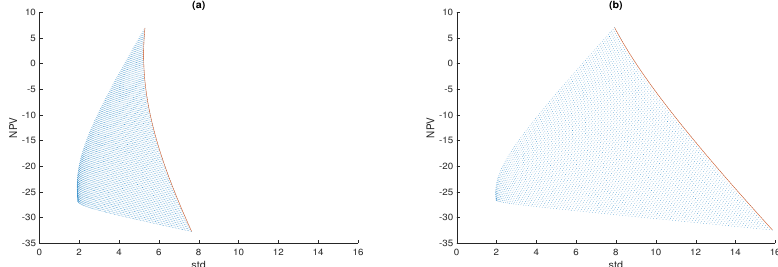
Figure 5. Power portfolio opportunity sets under the stochastic NPV metric: ( a ) the σ ca = 0.1 case; ( b ) the σ ca = 0.2 case. In the y -axis, NPV stands for expected NPV. Continuous red lines depict two-asset, gas and coal, portfolio opportunity